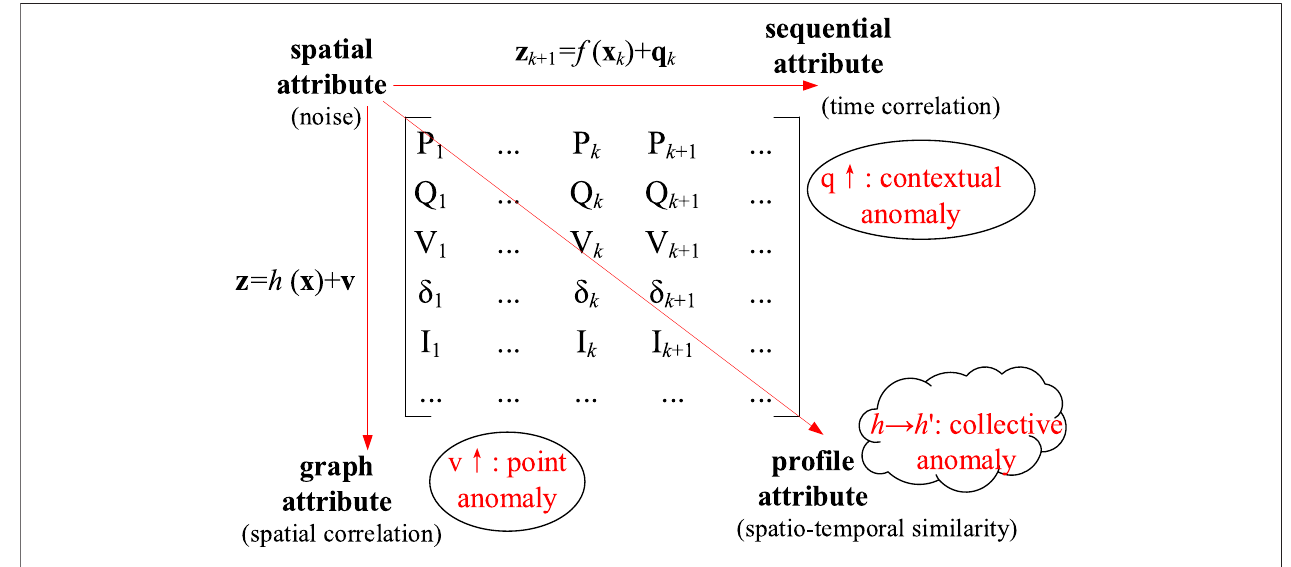
FIGURE 2 | Data attribute in